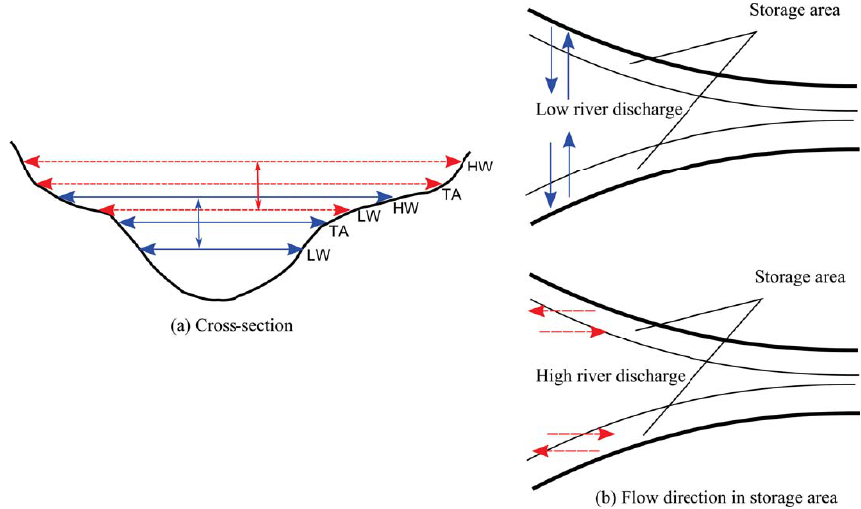
Figure 8. Variation of the water levels (LW: low water level, TA: tidally averaged water level, HW: high water level) in a cross-section (a) and the dominated flow direction in the storage area (b) . The blue drawn line represents the case with low river discharge, while the red dashed line represents the case with high river discharge.